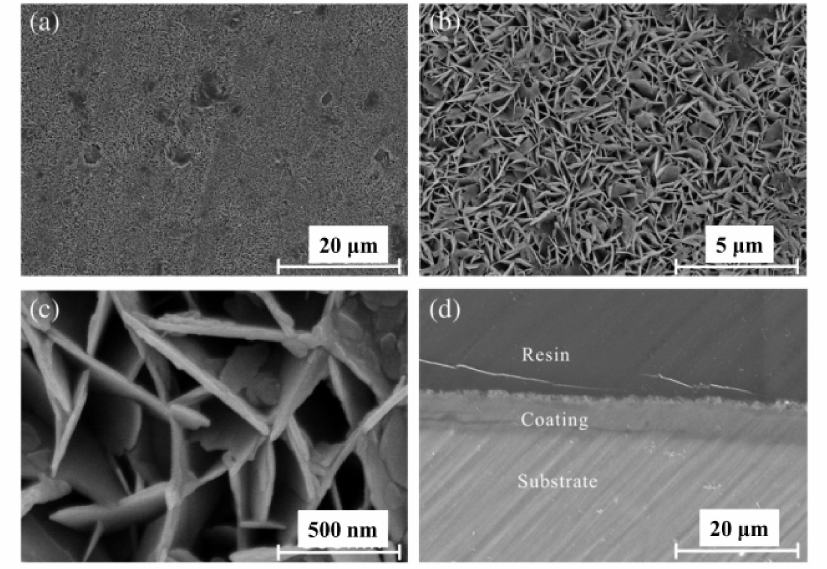
Figure 2. ( a – c ) The SEM images of the LDH coating on Mg alloy with different magnification; ( d ) the cross-sectional SEM images (crystallization with 48 h). Reprinted with permission from [20]; Copyright 2014